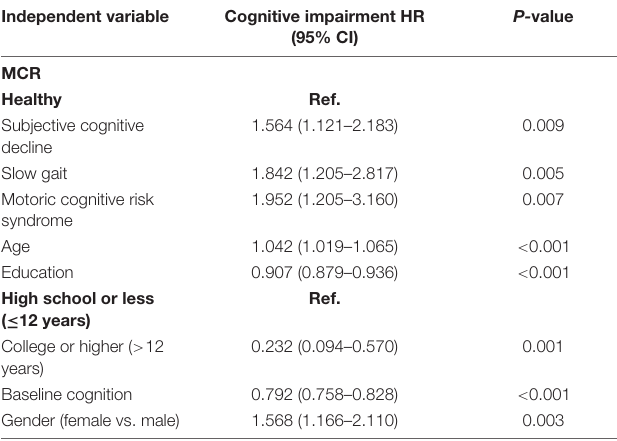
TABLE 2 | Multivariable Cox regression model for predicting development of cognitive impairment in 1,177